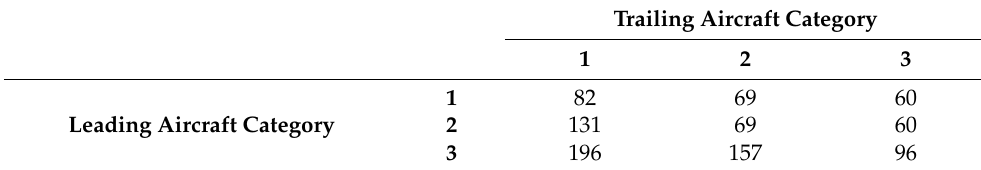
Table 1. MSTs (s) according to ICAO wake vortex safety rules [5].